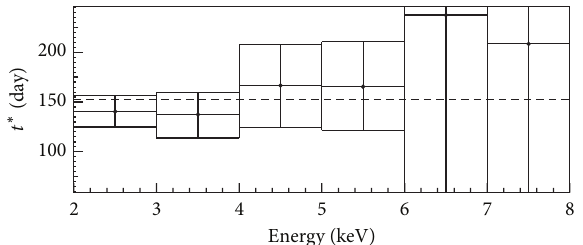
Figure 8: Phase 𝑡 ∗ as a function of the energy for the total exposure; here, the errors are at 2𝜎 . The vertical scale spans over ± a quarter of period around 2 June; other intervals are replica of it. An annual modulation effect is present in the lower energy intervals up to 6 keV and the phase agrees with that expected for DM induced signals. No modulation is present above 6keV and thus the phase is undetermined. See